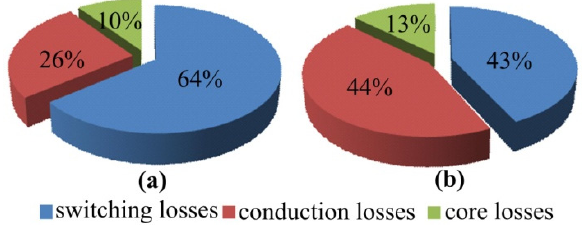
Figure 12. Losses distribution in DCM operation ( a ) at 1% of full load; ( b ) at 5% of full load.